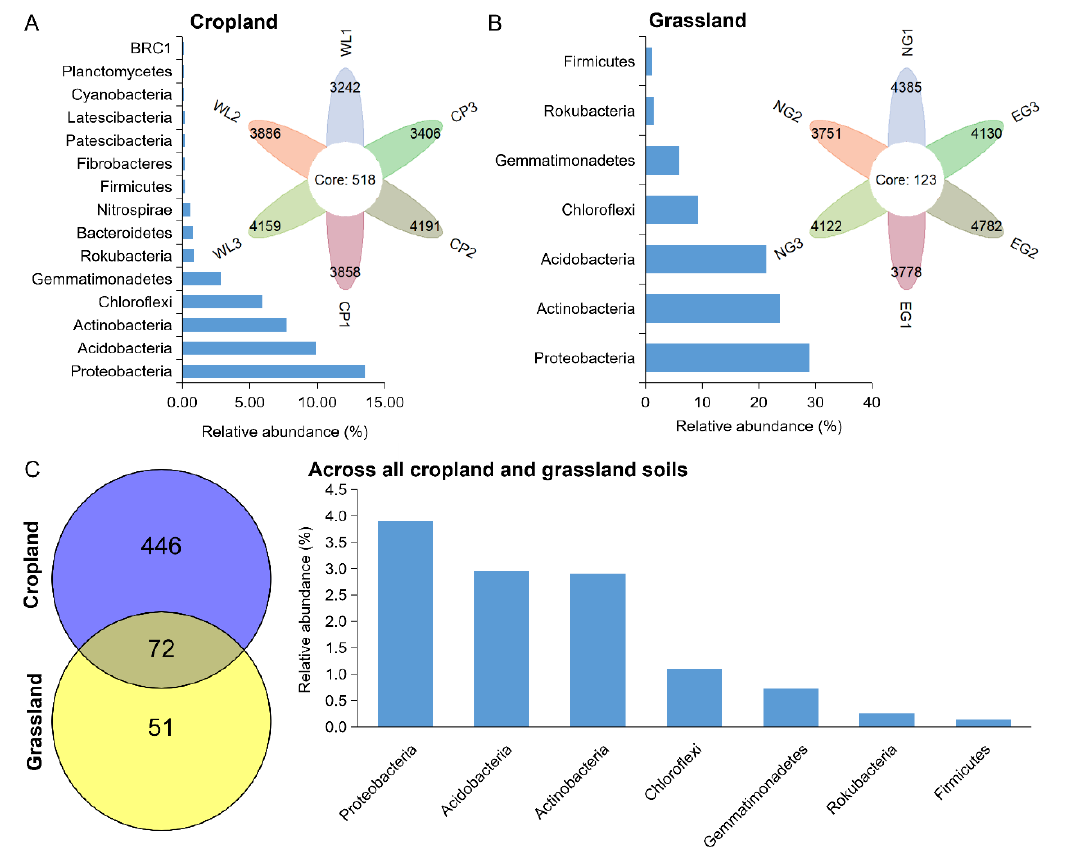
Figure 4. The composition of persistent bacteria in cropland ( A ) and grassland soils ( B ), and across all cropland and grassland soils ( C ).